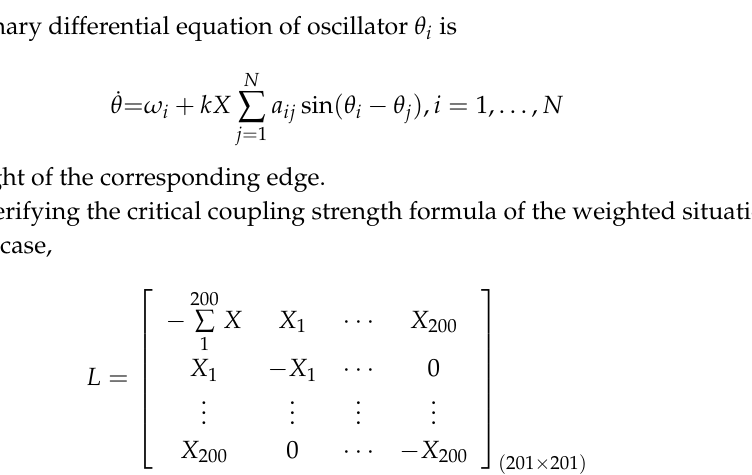
Figure 4. Probability density function of Gaussian distribution.